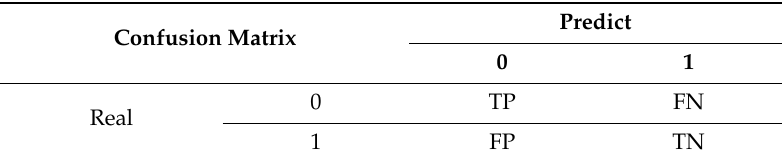
Table 3. Binary confusion matrix.